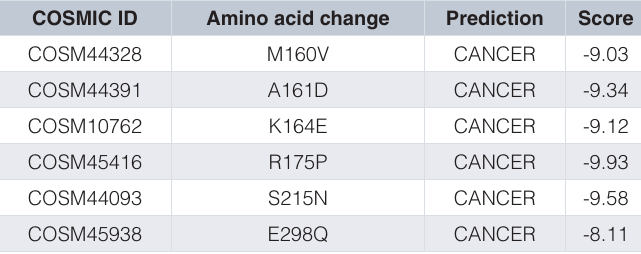
Table 10. FATHMM server; cancer association predictions result of the non-synonymous changes found in TP53 gene exon 5–8.